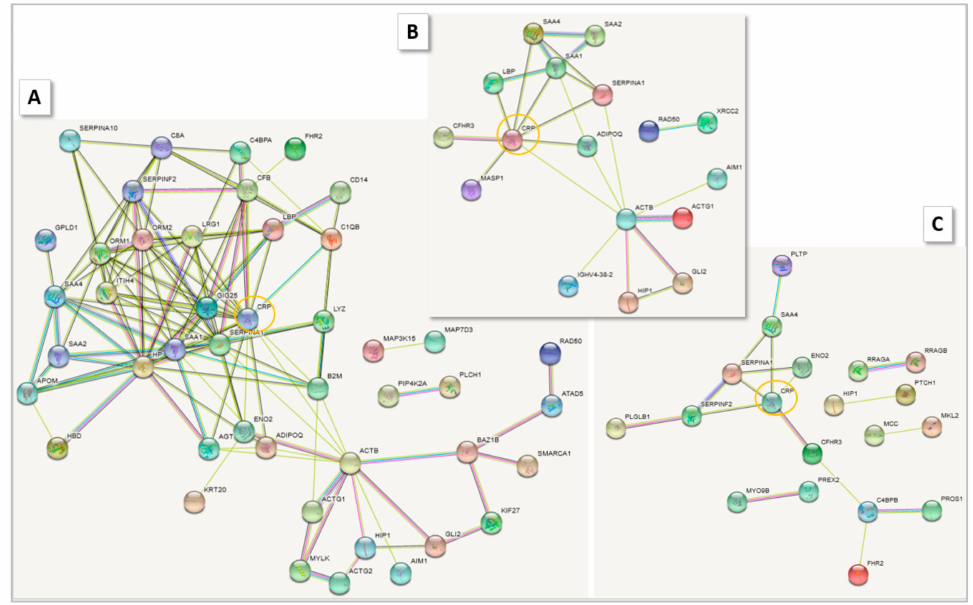
Figure 9. String networks for ( A ) G6, ( B ) G5 and ( C ) G1, of the most abundantly upregulated proteins (confidence at least 50) in the comparison to HCtr. CRP is